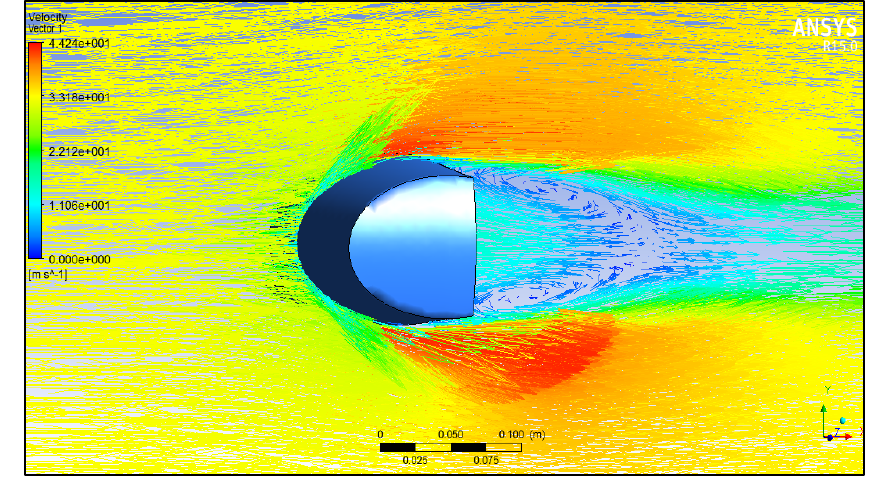
Figure 13. Velocity contures of modified mirror (120 km/h)